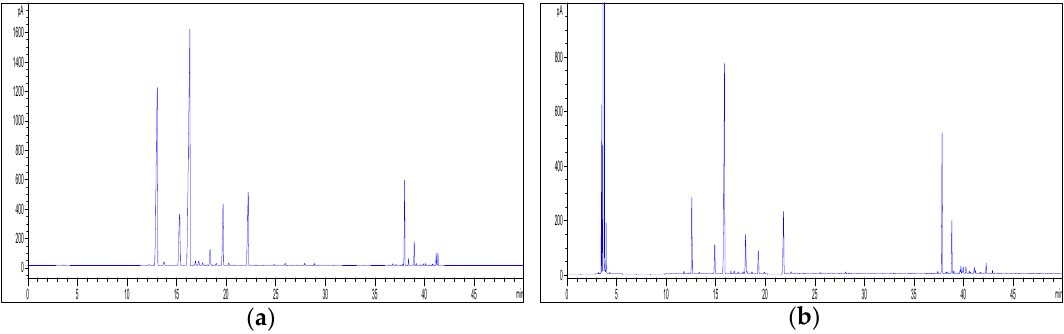
Figure 10. Effect of the equilibrium time and extraction time on the HS-SPME-GC-FID profiles of hemp inflorescences (sample C3) with the DVB/CAR/PDMS fibre at 40 °C: ( a ) equilibrium and extraction time of 20 and 10 min, respectively; ( b ) equilibrium and extraction time of 30 and 20 min, respectively.